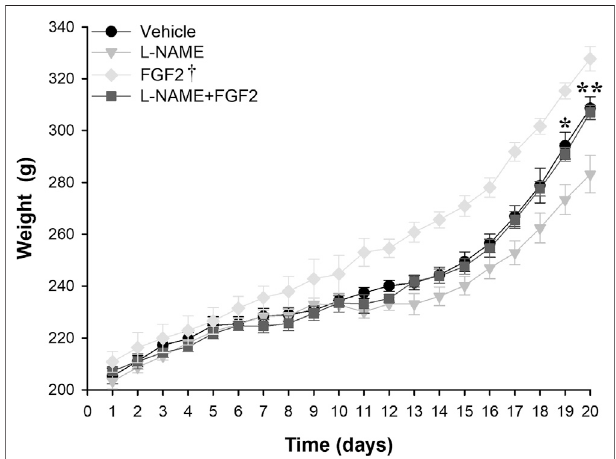
FIGURE 3 | Weight gain effect of the administration of 666.6 ng/kg of rhFGF2 in Sprague Dawley rats during pregnancy in the PE-like model induced by L-NAME. The fi gure shows weight measurements in the vehicle, L-NAME and L-NAME + FGF2 groups during the experimental protocol. Weight measurements were taken daily. Data are expressed as mean ± standard error of seven rats. p -values for the comparison between groups were obtained using one-way analysis of variance (ANOVA). * p < 0.05, ** p < 0.001. † Compared with L-NAME, FGF2 group had p -values < 0.05 from day 11 to day 20.